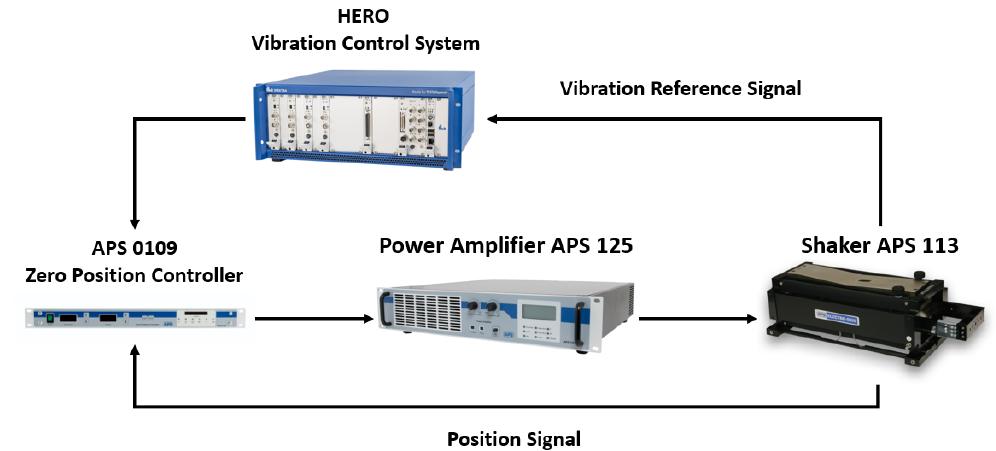
Figure 3. Block diagram of calibration system.